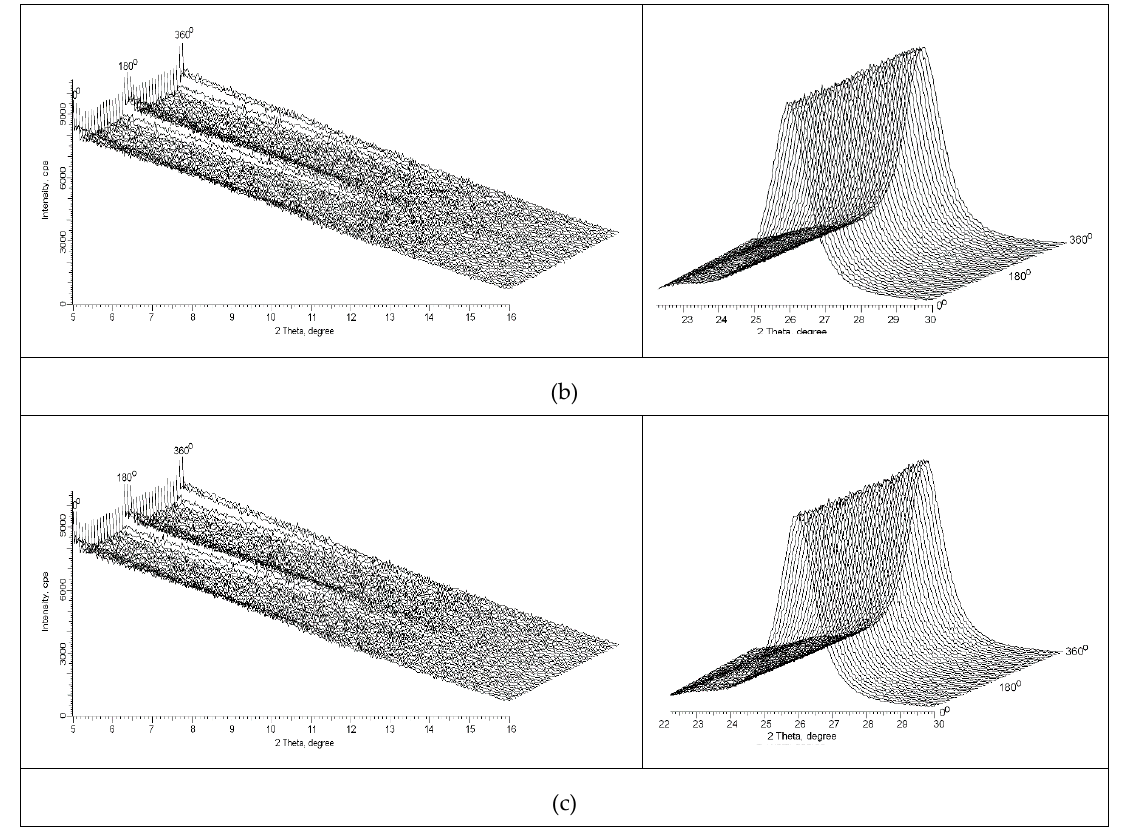
Figure 4. X-ray diffraction patterns of test samples polymer films: ( a ) irradiated Kr 13+ ions; ( b ) irradiated Kr 14+ ions; ( c ) irradiated Kr 15+